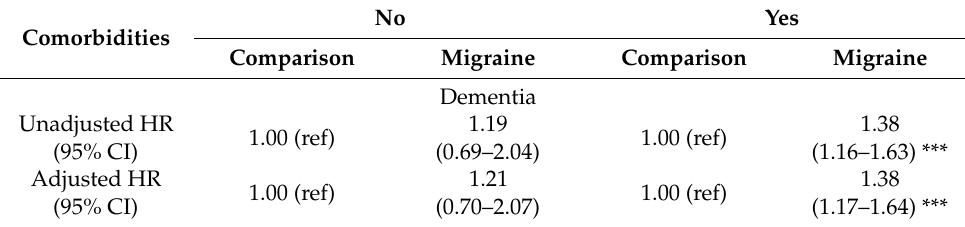
Table 4. Hazard ratios of dementia by comorbidities among the sample patient.